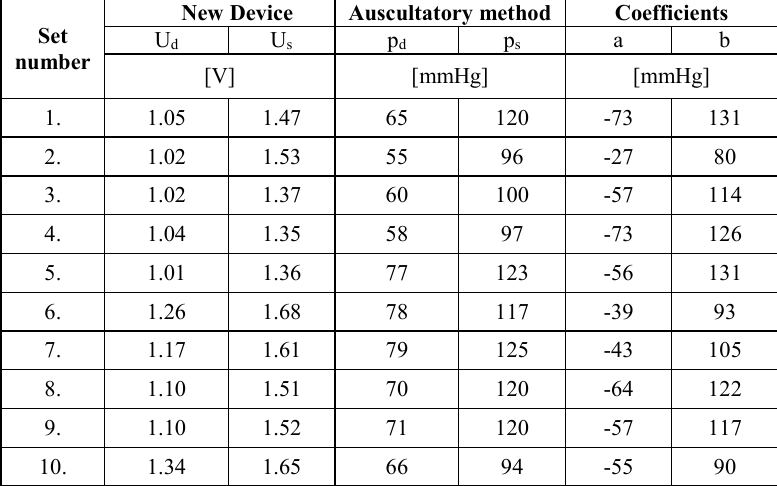
Table 1. Obtained data sets and calculated